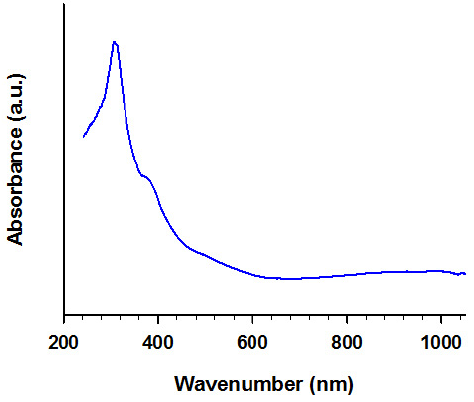
Fig. 5. DRS pattern of the Fe-ZIF-8 nanocatalyst.